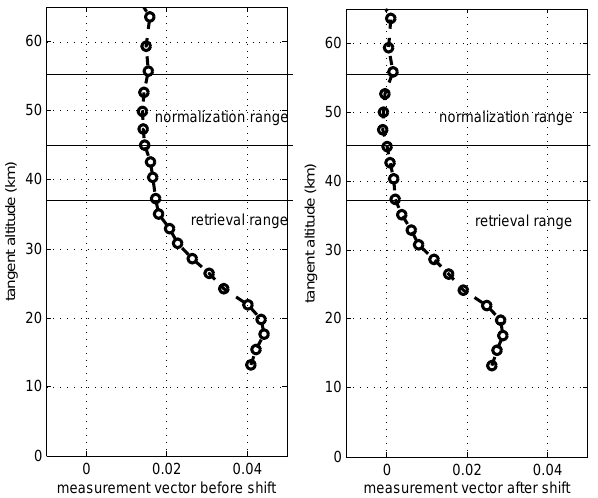
Fig. 2. The measurement vectors. The vector shown in the left hand panel is calculated using Eq. ( 6). The vector shown in the right hand panel is shifted by a constant such that the average value is zero over the normalization